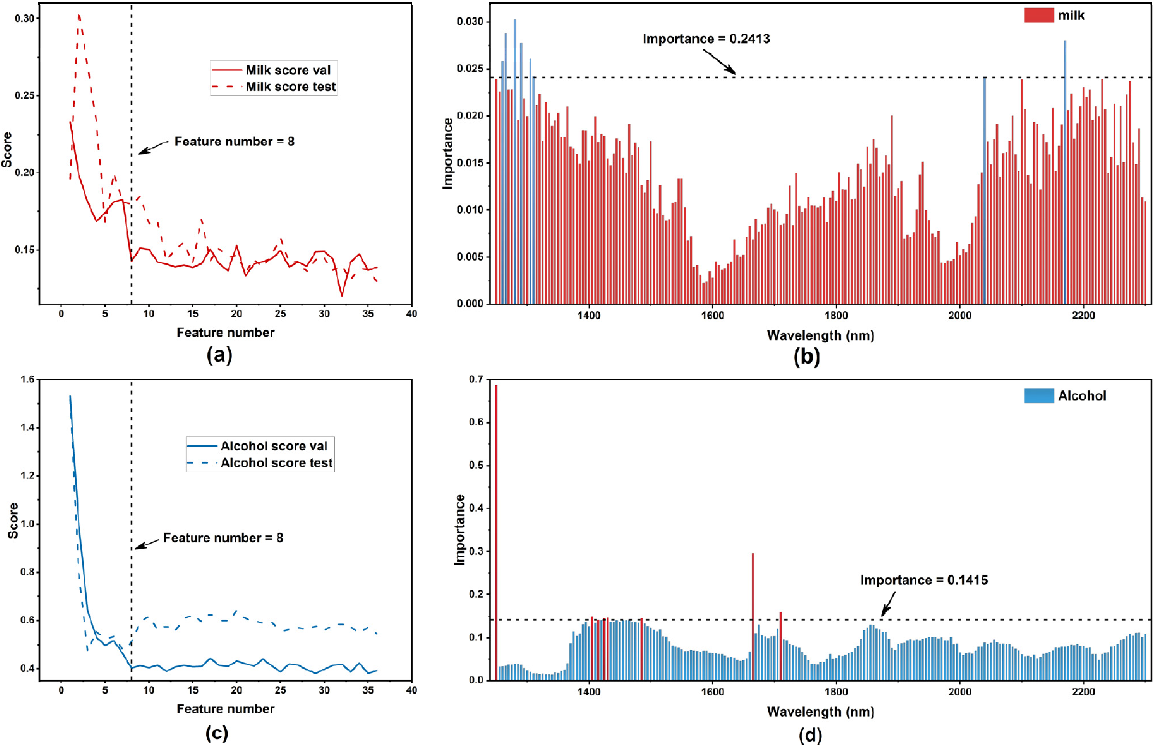
Figure 5. Results of the “score val” (RMSEV) and permutation importance of the two samples. ( a ) “score val” (RMSEV) of milk samples. We also calculated RMSEP as “score test.” ( b ) degrees of permutation importance of the milk samples; ( c ) “score val” (RMSEV) of alcohol samples. We also calculated RMSEP as “score test.” ( d ) permutation importance of alcohol samples.